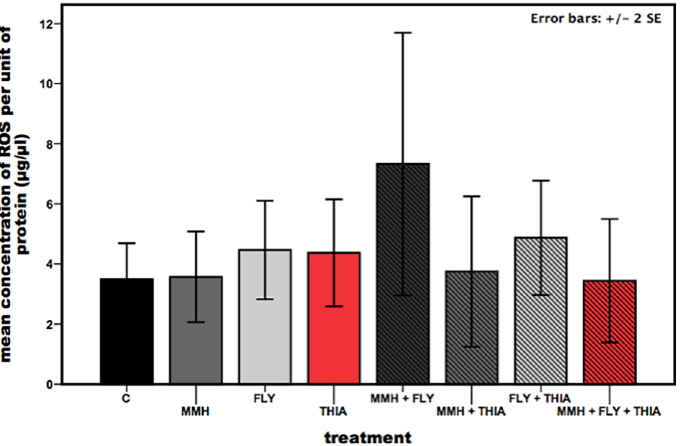
Fig 4. ROS concentration in the gut of honeybees after being exposed to different agricultural agents. Differences in the mean concentration of reactive oxygen species in honeybee midguts, adjusted to the units of protein, when feeding on different diets. Diets were inoculated with potential agricultural stressors (C = control, MMH = E . faecalis strain MMH594, FLY = E . faecalis strain FLY1, THIA = thiacloprid). Results represent mean values ± 2 s.e.m, ANOVA, n = 16 for each treatment group. Bars are indicated in: black = control, dark-grey = MMH, light-grey = FLY, red = THIA, shaded black = MMH+FLY, shaded dark-grey = MMH+THIA, shaded light-grey = FLY+THIA, shaded red =